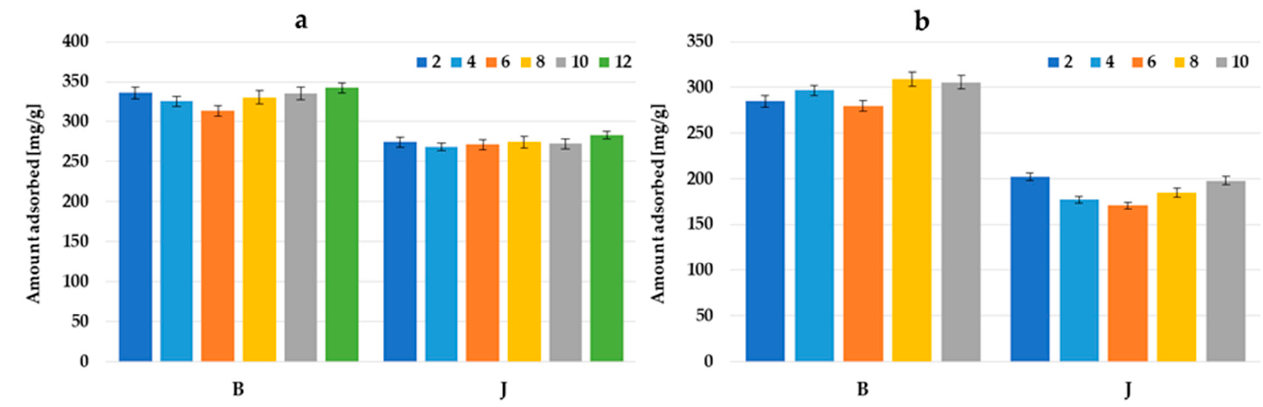
Figure 9. Effect of pH on methylene blue ( a ) and malachite green ( b ) adsorption on the carbonaceous materials derived from the used carbon filters.